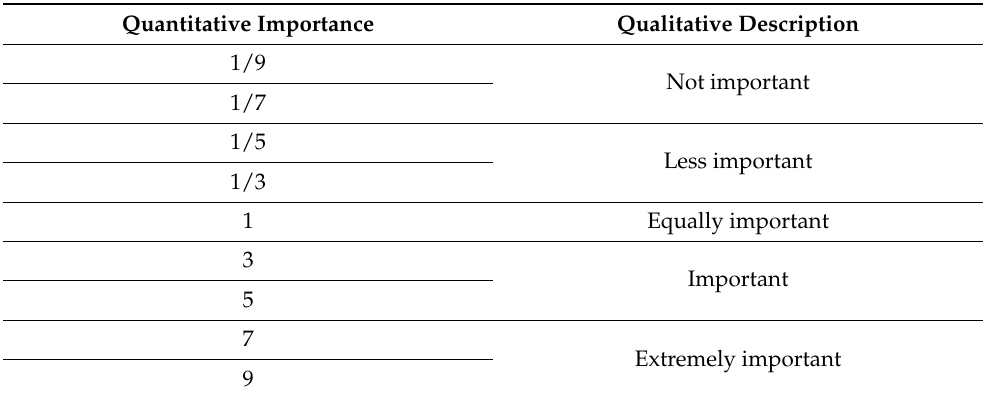
Table 4. Scale used to represent the importance of various indicators, factors, and components considered in